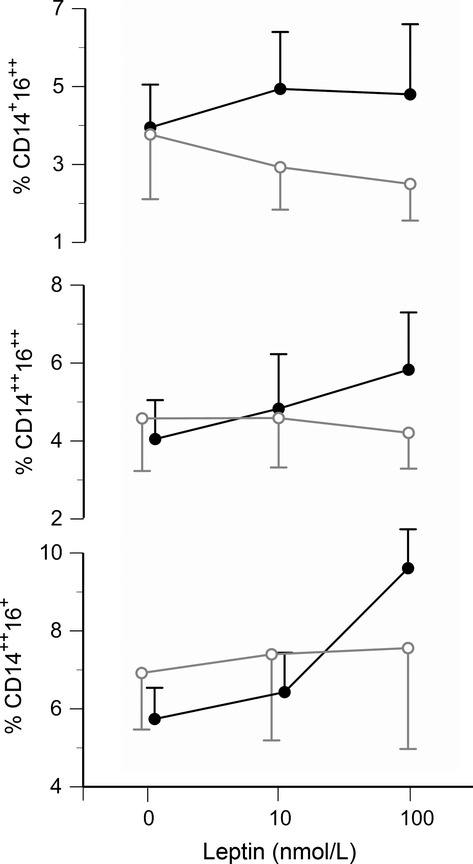
Leptin‐induced expression of CD16 on CD86+ monocytes in vitro. The three panels show the percentages of each cell type after 18 h of incubation in vitro with 0, 0.16, or 1.6 μg/mL leptin. The solid black symbols represent cells from men (n = 6) and the open gray symbols represent cells from women (n = 5). A significant main effect by leptin was observed for CD14++CD16+ monocytes (bottom panel, P = 0.02), and significant leptin × sex interactions were observed for CD14++CD16++ and CD14+CD16++ cell populations (middle and top panels, both P = 0.03). In the men only, leptin‐induced increases were statistically significant for the CD14++16+ (P = 0.0002) and CD14++16++ (P = 0.004) populations.